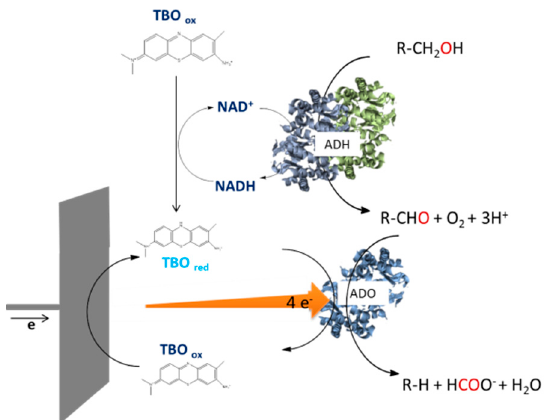
Figure 13. Schematic diagram of a bioelectrochemical enzymatic cascade for the preparation of alkenes [182] .